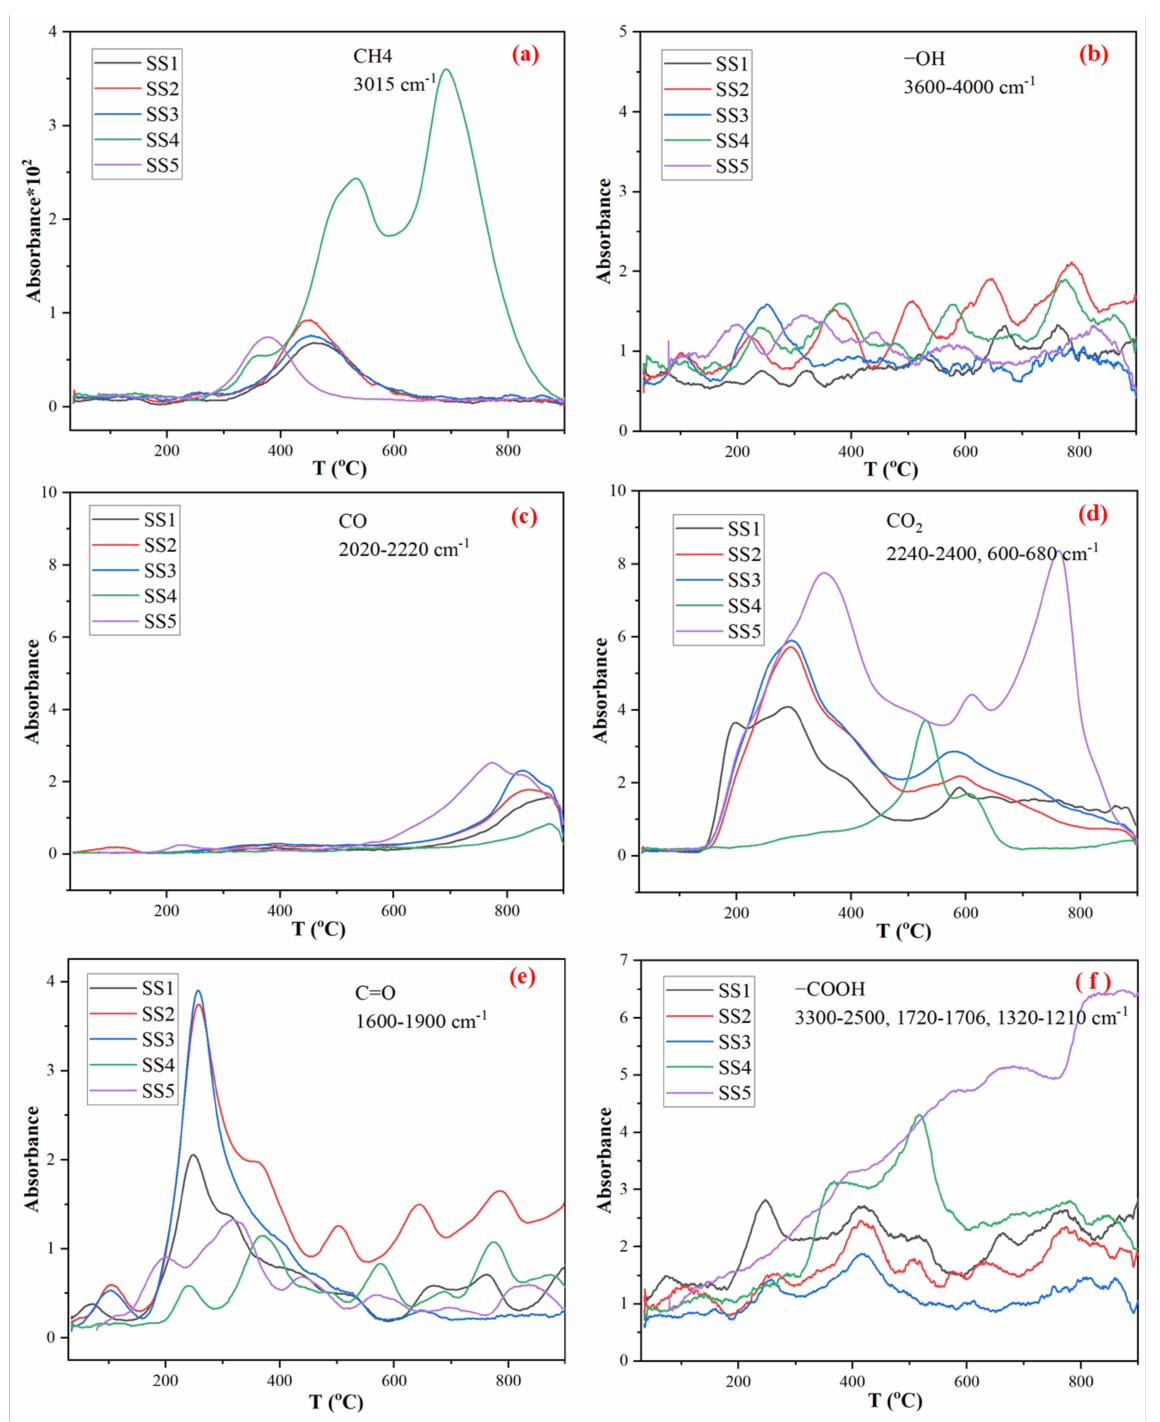
Figure 5. Absorbance curves of gaseous products and main functional groups from FTIR. ( a ) CH 4 ; ( b ) − OH; ( c ) CO; ( d ) CO 2 ; ( e ) C=O; ( f ) −